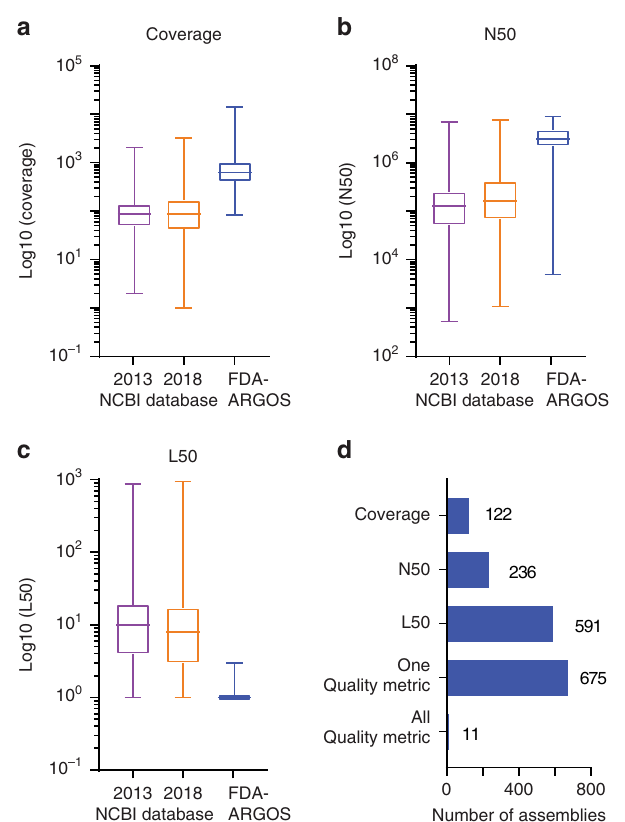
Fig. 3 FDA-ARGOS reference genome assemblies quality